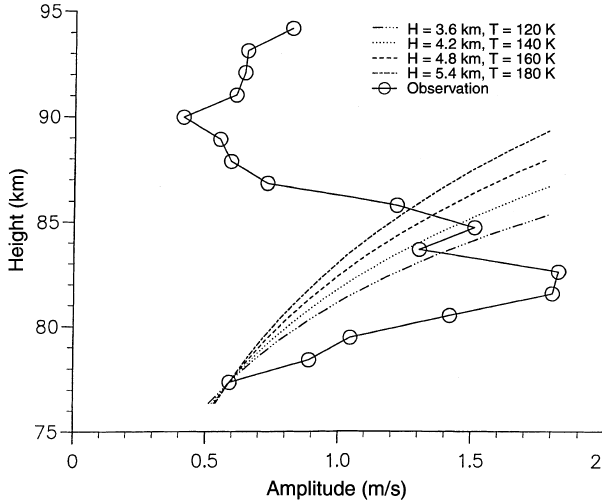
Fig. 3. The amplitude-height profile for the quasi-monochromatic gravity wave observed between 06:00–12:00 UT on 31/7/92. Also indicated are the predicted amplitude growth curves for temperatures of 180, 160, 140 and 120 K isothermal